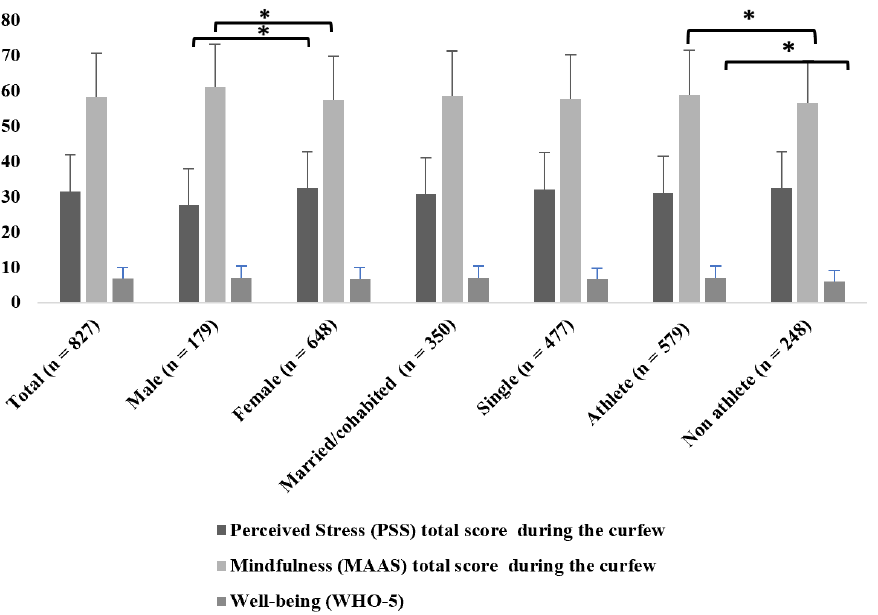
Figure 1. Differences of perceived stress (PSS-14), trait mindfulness (MAAS), and well-being (WHO- 5) total scores regarding gender, sporting attitude, and marital status (* p ≤ 0.001 mean ± standard